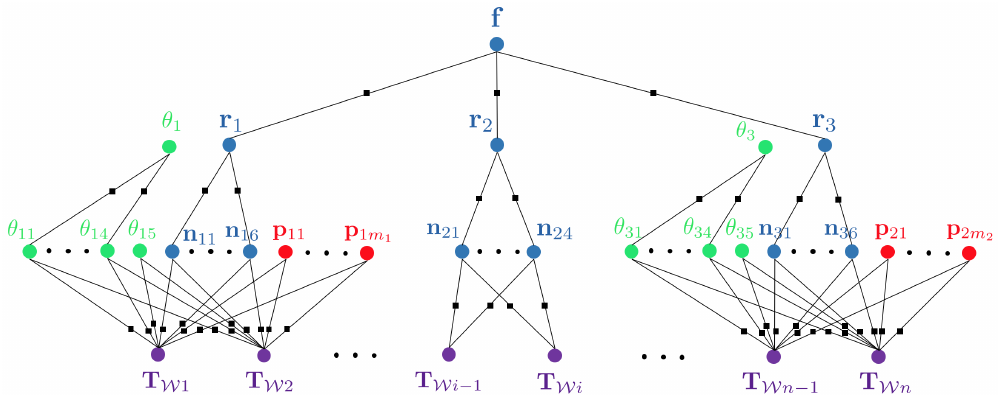
Figure 5. Factor graph for a visual SLAM problem in which a robot moves from one room through a corridor into another room. Both rooms contain 4 chairs of similar shape and one table. The hierarchical structure of the environment is exploited for the imposition of higher-order constraints. The bottom level of the environment representation consists of object parametrisations ( θ 11 , . . . , θ 14 represent chairs in room one, θ 31 , . . . , θ 34 chairs in room 3, and θ 15 and θ 35 tables in room 1 and 3, respectively), background planes n xy (6 for room 1 and room 3, and 4 for room 2, which is the corridor), and point clouds for the representation of unstructured segments of the environment. At the centre level, we have variables r x which parametrise the different rooms in the environment (e.g., parameters of a rectangular footprint and a room height). The factors between the bottom and the centre layer enforce the consistency of the room parameters and the individual planes, and thus implicitly enforce higher-order constraints such as orthogonality of planes. We furthermore have one average parametrisation θ x used to enforce the similarity of all objects of similar shape within each room. Factors between the centre and the top layer finally constrain the individual room parameters to be consistent with some floor parameters f (e.g., the vertical coordinate of the floor may be enforced to be the same in each